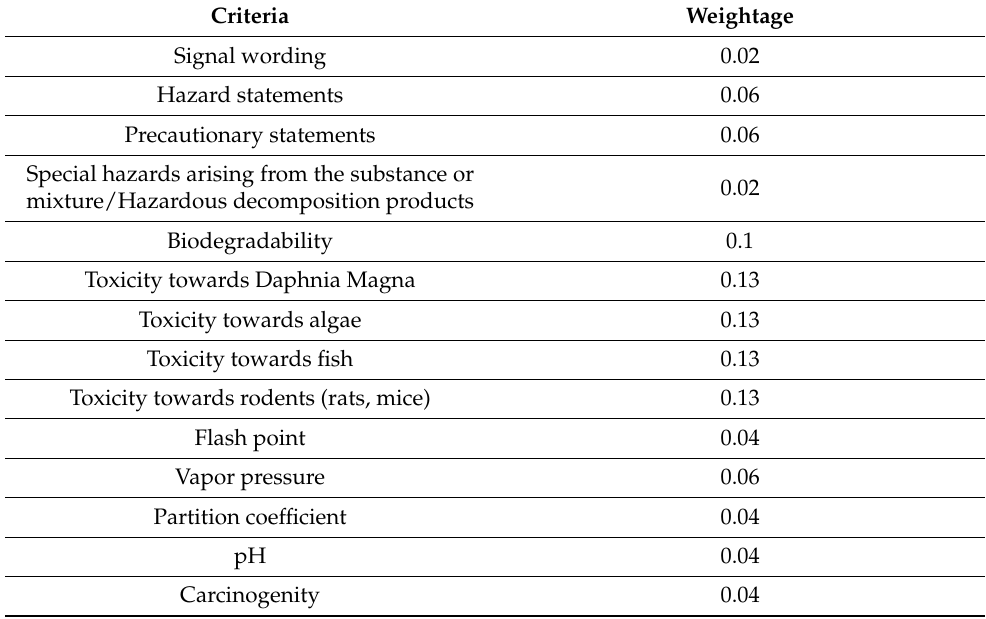
Table 1. Table showing the criteria and the weightage employed in the study for the TOPSIS Ranking.